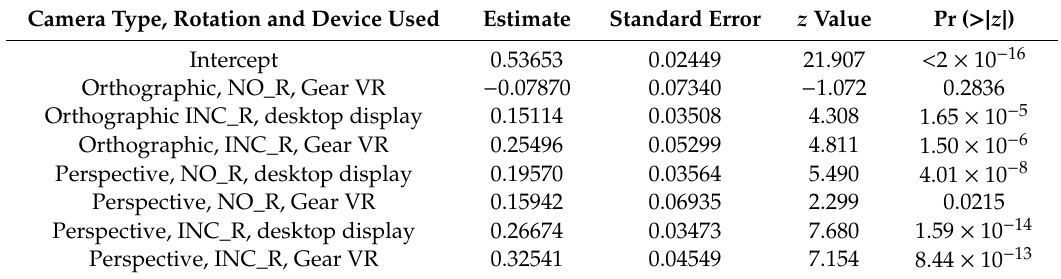
Table 31. Logistic regression analysis results investigating the variables camera type, rotation and device used.